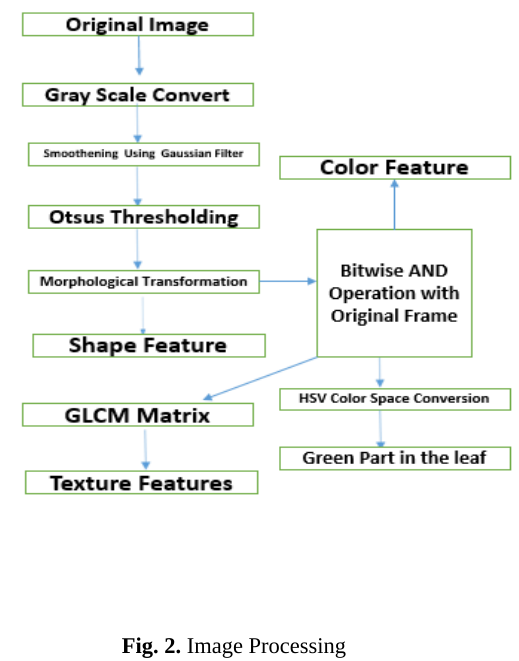
Table 1 . Specifications for Datasets Fig. 1. Proposed System